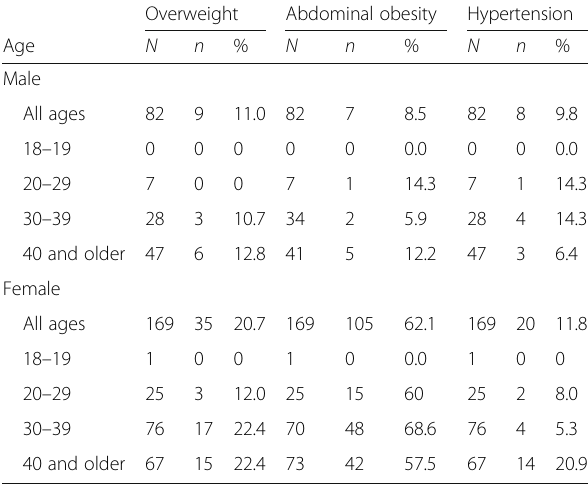
Table 2 Prevalence of overweight, abdominal obesity,